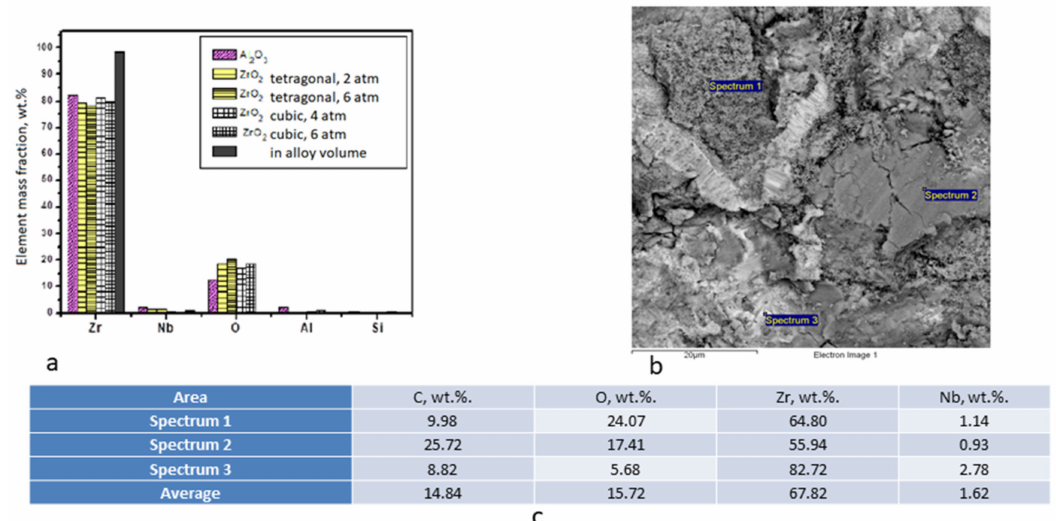
Figure 3. Chemical composition of the surface layer of alloy depending on the type of abrasive and treatment mode. ( a )—X-ray fluorescent analysis. ( b )—Chart of chemical analysis of the surface areas of a sample treated with T–ZrO 2 at a pressure of 6 atm and ( c )—EDX from selected areas (from ( b